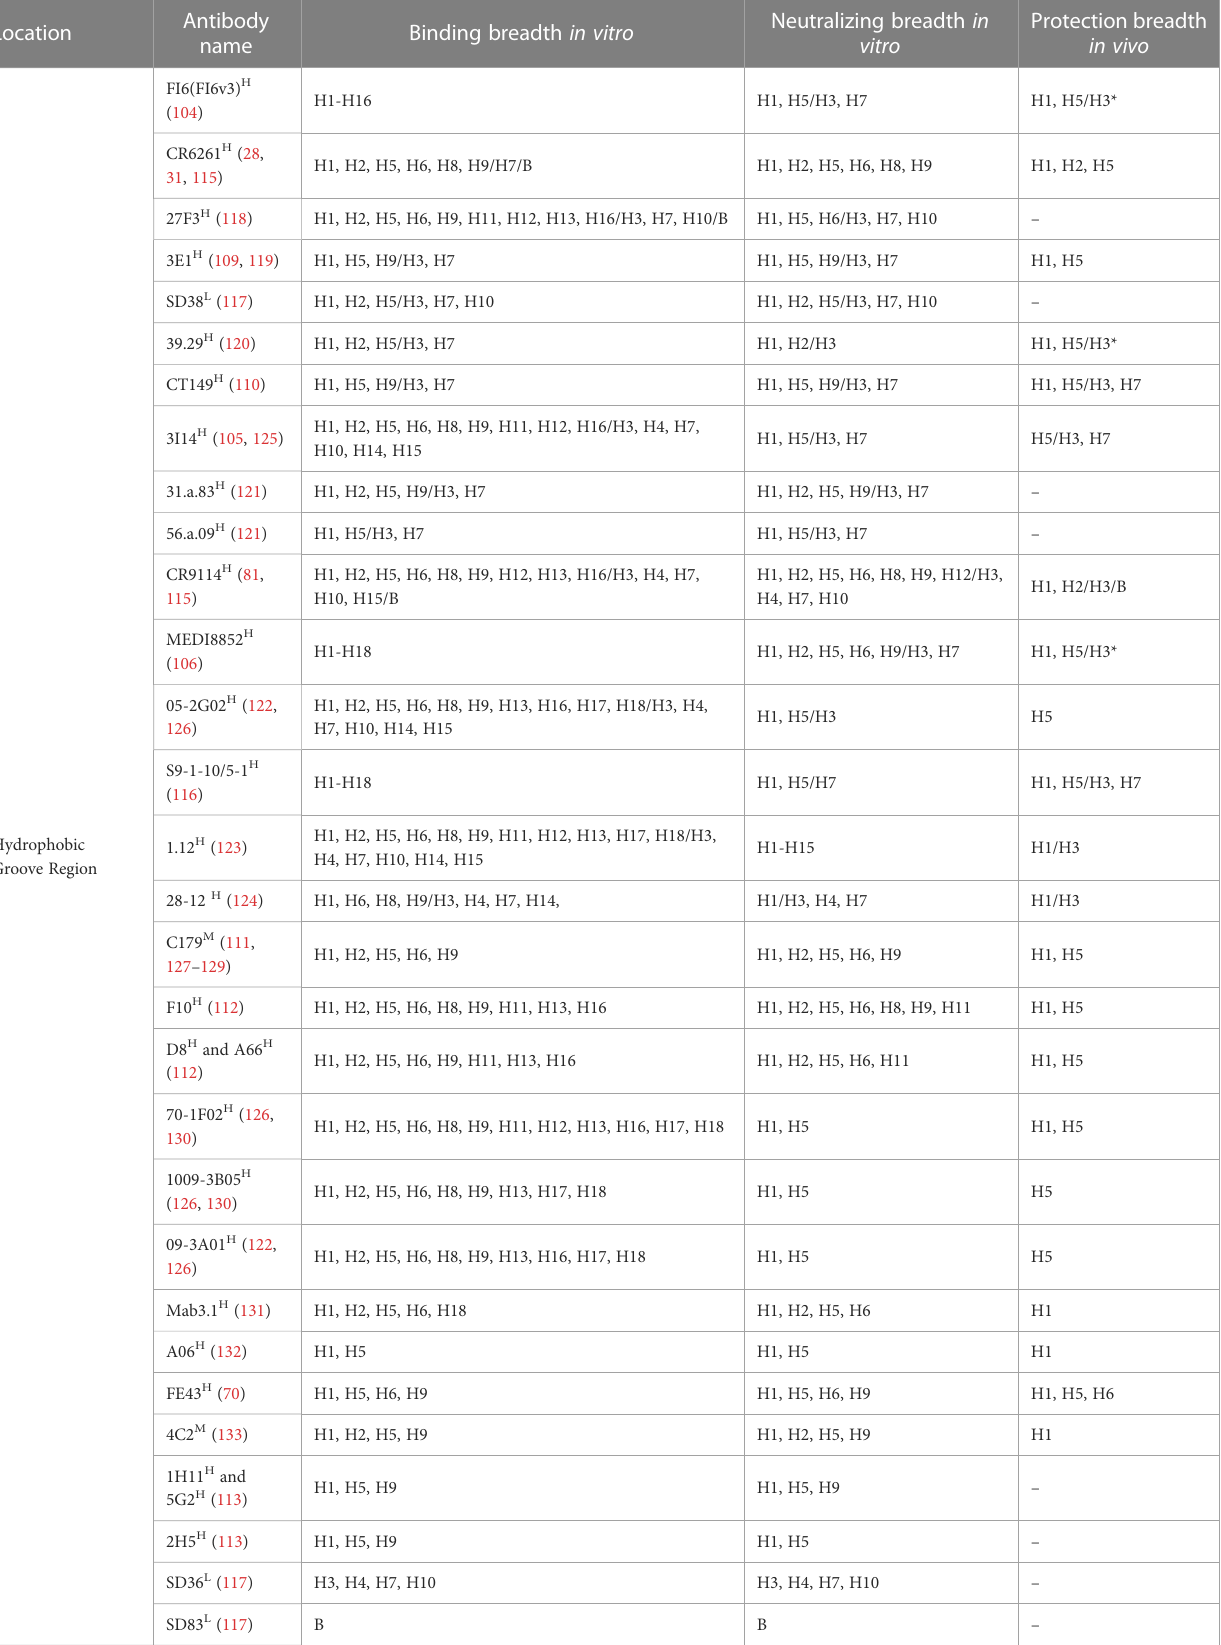
TABLE 2 Characteristics of broadly neutralizing antibody binding to the HA stem